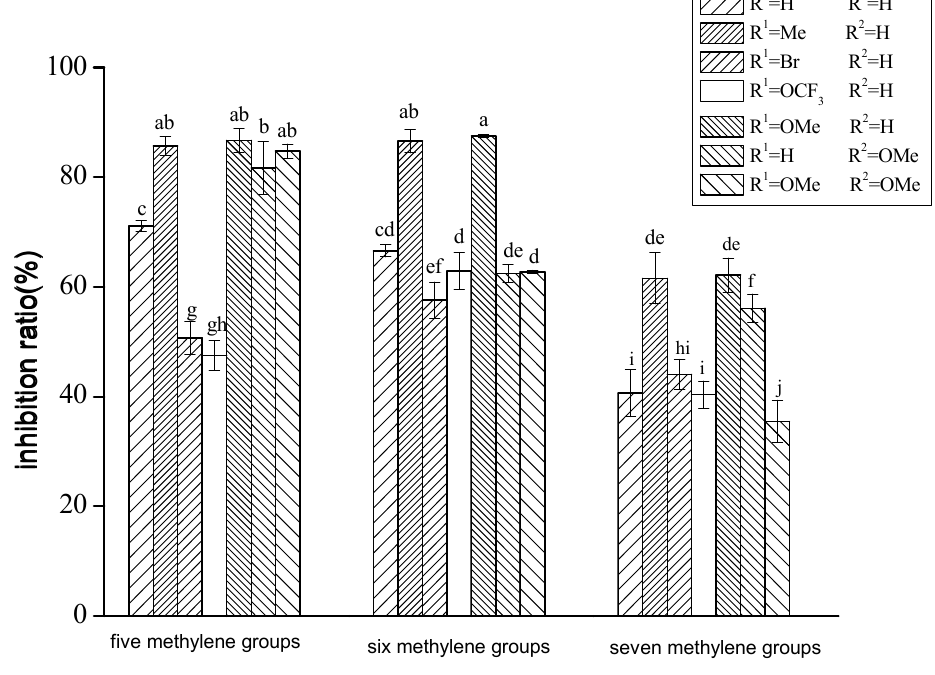
Figure 3. Inhibitory activity of coumarin–BMT hybrids. Note: Data are normalized as a percentage of control, and are expressed as the means ± SEM of at least three independent experiments, and the measurements were carried out in the presence of 2 µ M compounds. There are no identical letters on the superscript of the data, showing that they have statistically significant difference ( p ≤ 0.05) between the two groups. Any letter being the same on the superscript of the data shows that they have no difference ( p > 0.05) between the two groups. Statistical analysis was performed with ANOVA followed by Duncan’s multiple range test (DMRT).